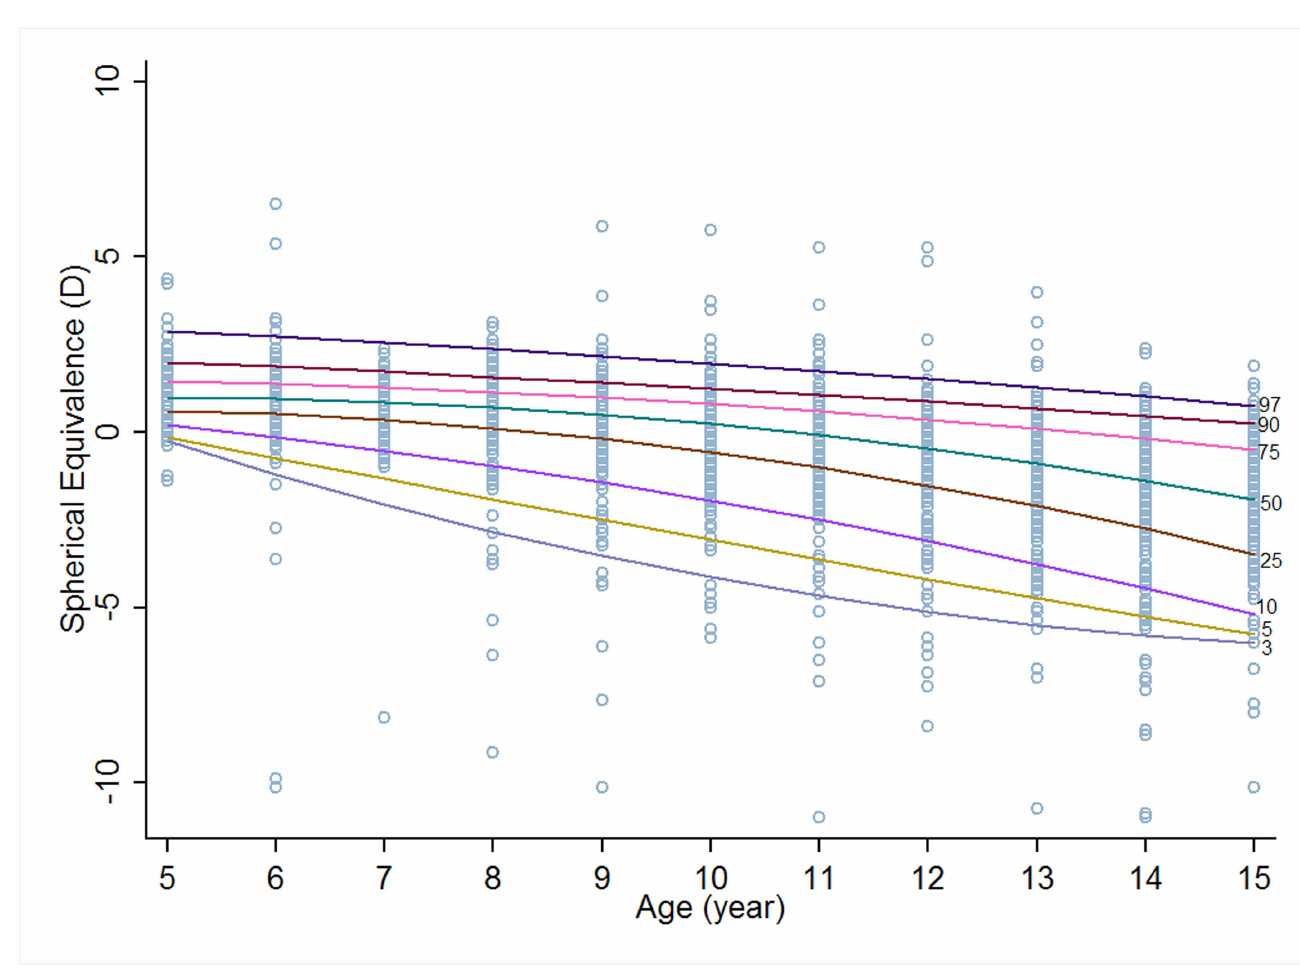
Fig 2. Percentile curves for urban Chinese girls based on cross-sectional data.